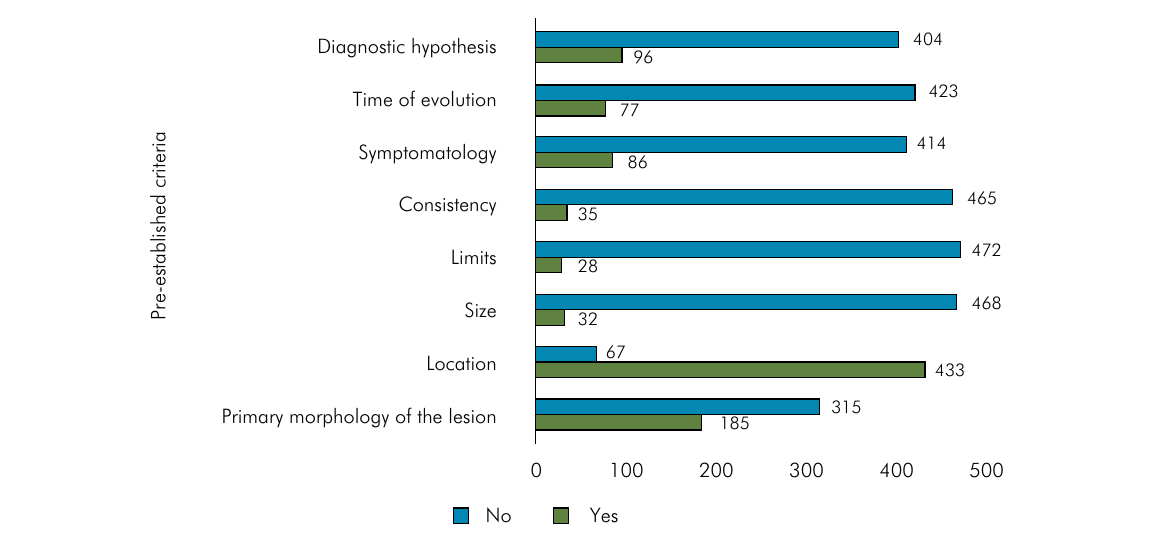
Figure. The pre-established criteria for referral letters.